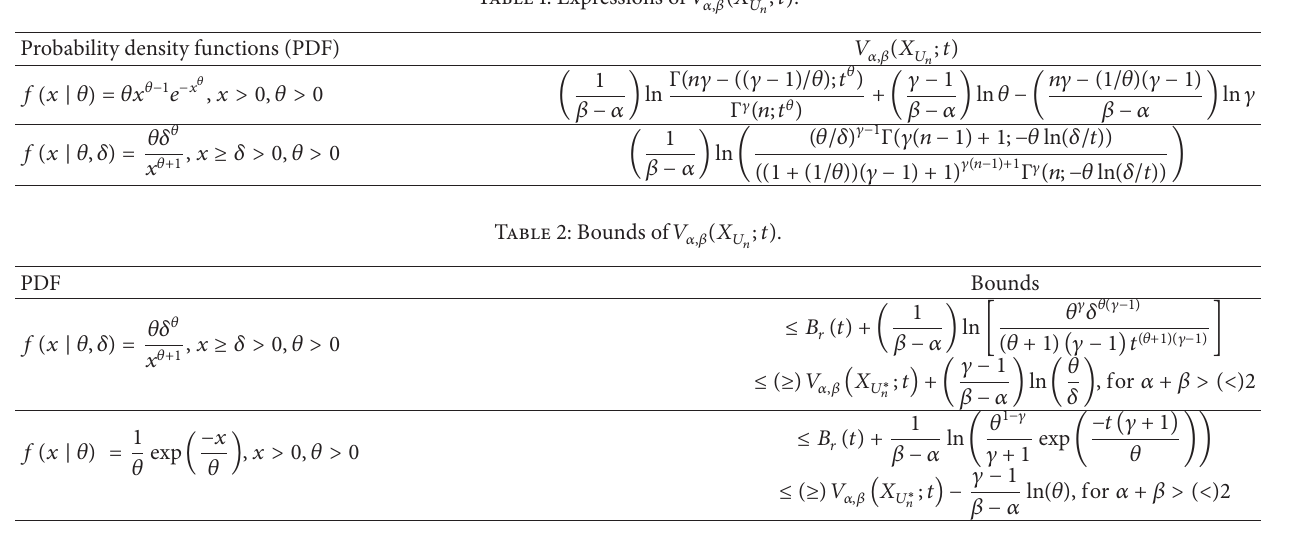
Table 1: Expressions of 𝑉 𝛼,𝛽 (𝑋 𝑈